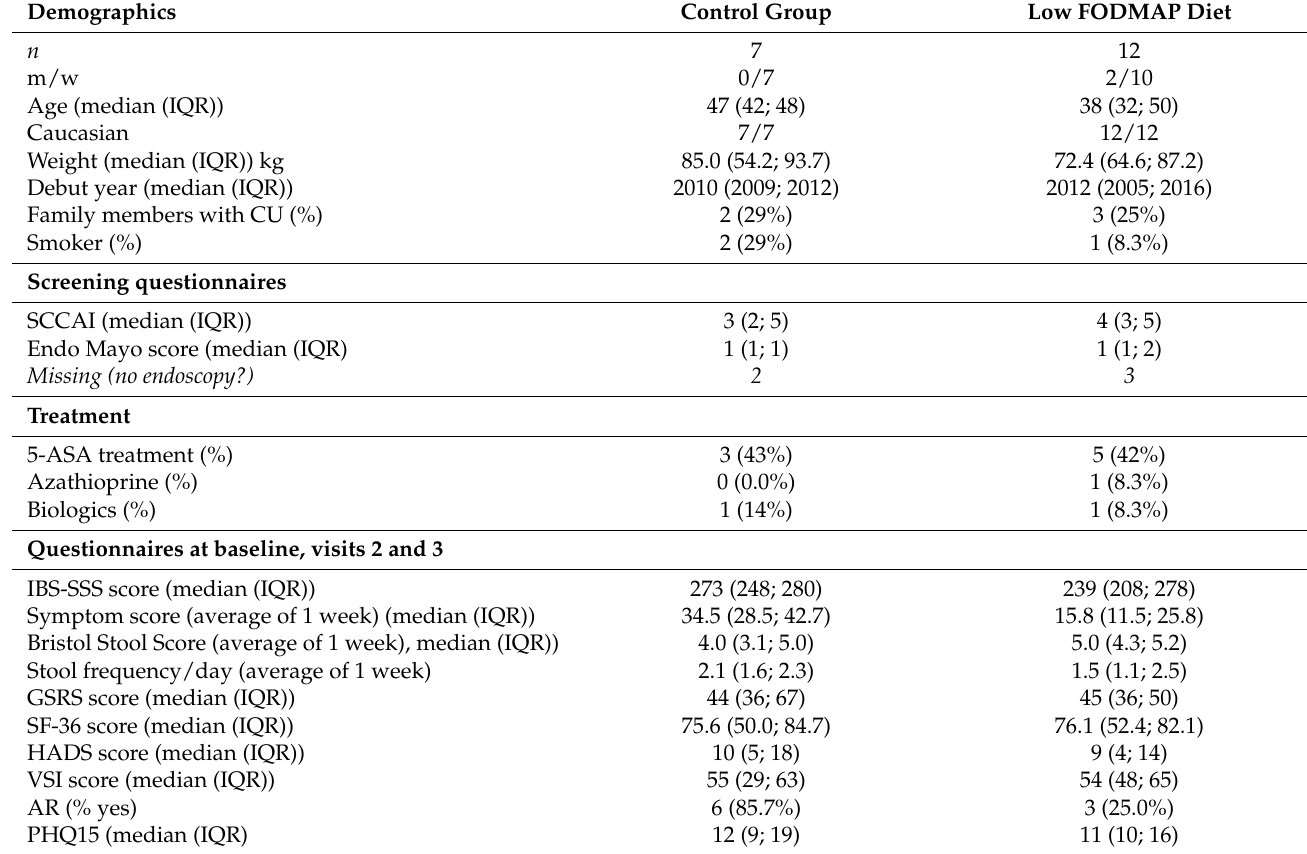
Table 2. Baseline participant demographics.